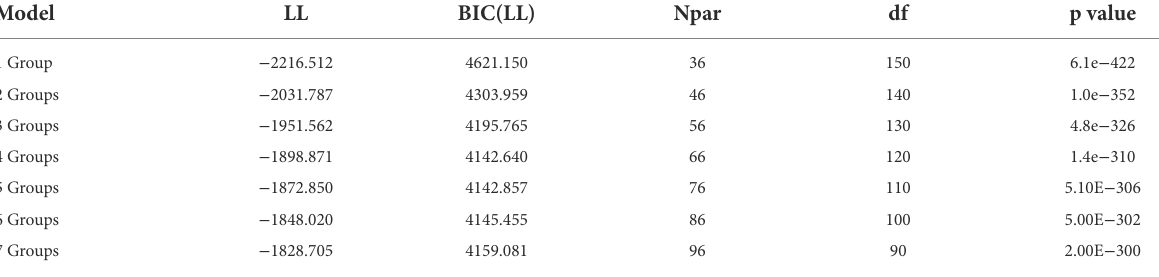
TABLE 5 Goodness-of-Fit statistics for LCFA models on WFFS (N = 186). Model